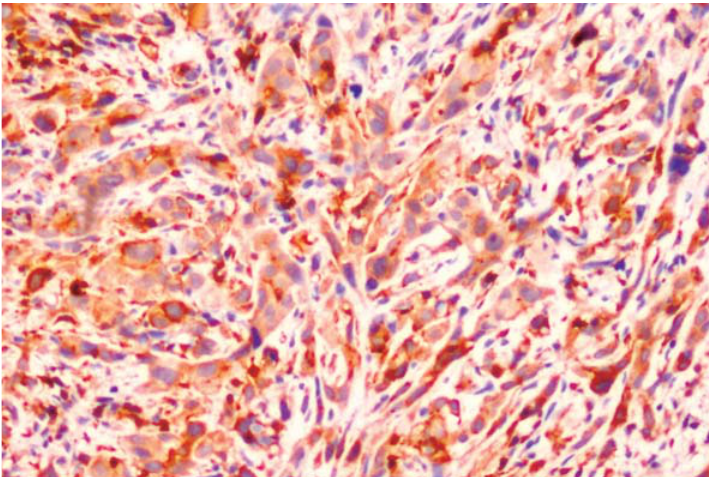
Figure 4- Oral squamous cell carcinoma (OSCC) showing type 4C diffuse cord like pattern of invasion (S100A4,